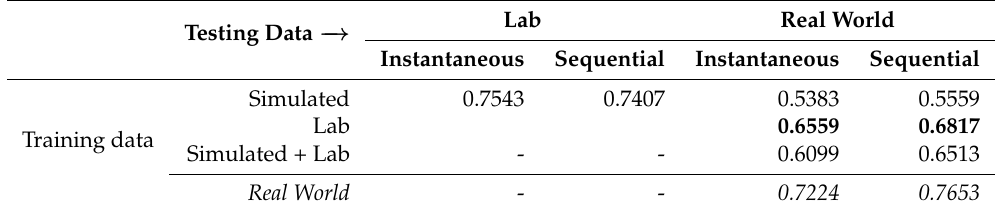
Table 2. Accuracy of gender classification for different training and testing